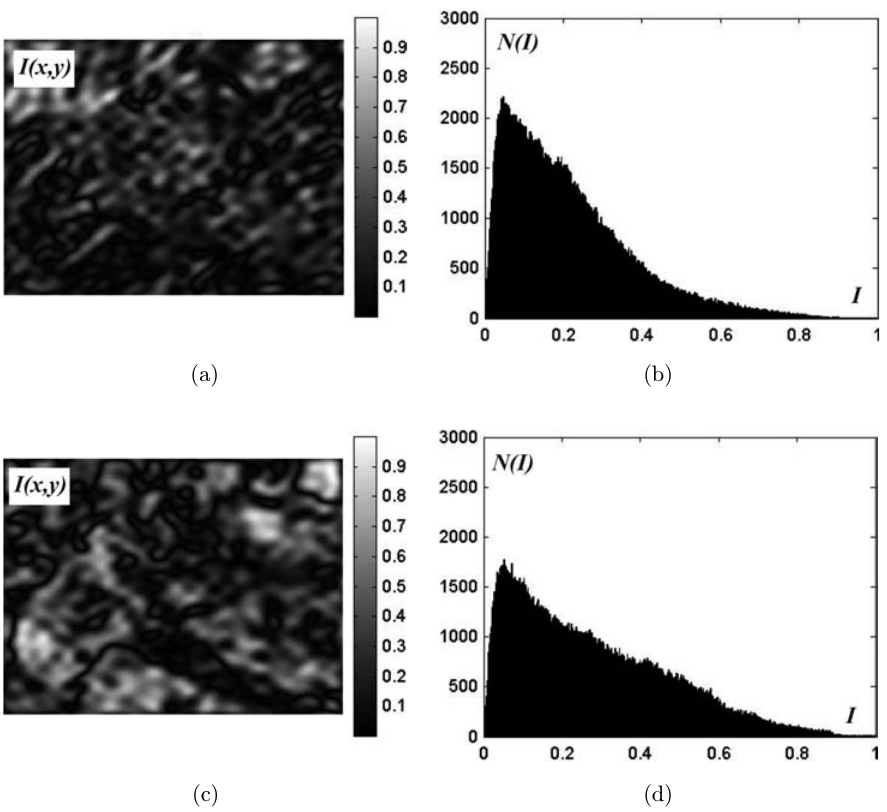
Fig. 3. Coordinate ( I ð x ; y Þ ) and statistical ( N ð I Þ ) distributions of laser auto°uorescence intensities of histological section of biopsy of cervix uteri endometrium (cervical microinvasive carcinoma) for the following polarization states: (cid:4) 0 ¼ 0 (cid:6) — fragments (1), (2); (cid:3) (cid:4) — fragments (5), (6). Explanations are in the (cid:4) (cid:6) — fragments (3), (4); (cid:4) 0 ¼ 90 0 ¼ 0